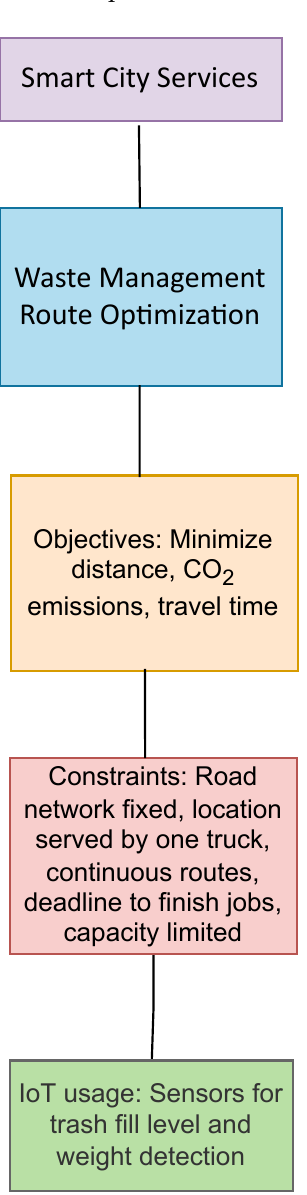
Figure 2. Optimization applications in Smart City